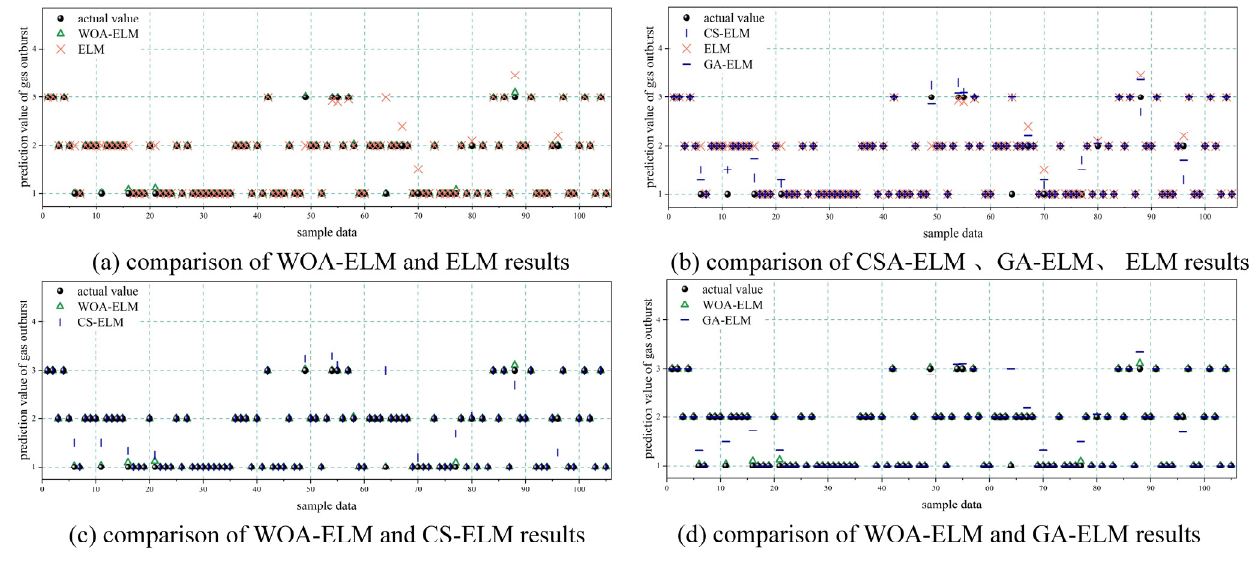
Figure 5. Comparison of predicted values before and after model optimization. Table 9. Sample deviations of some gas outburst hazard predictions.